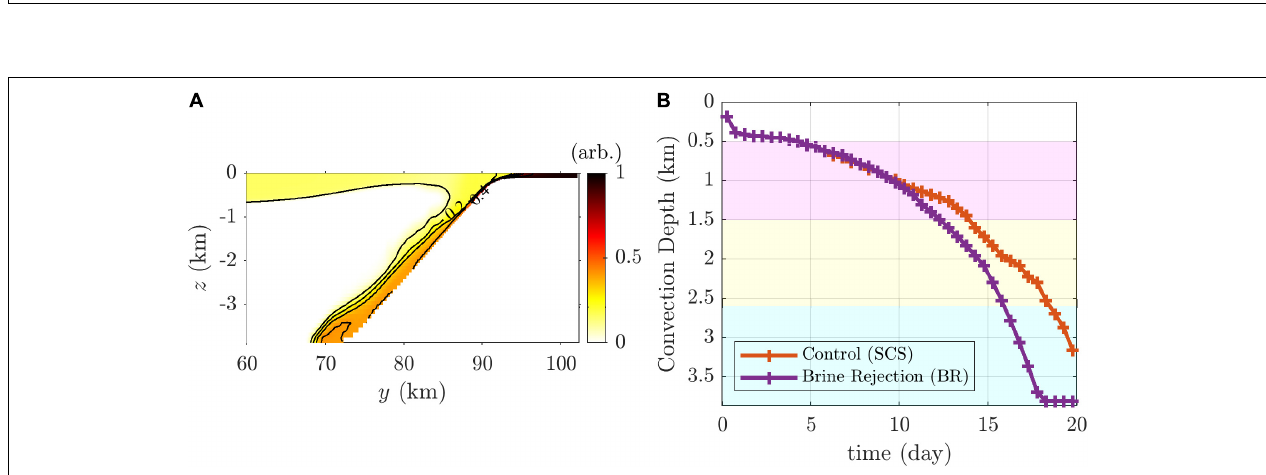
Frontiers in Marine Science |